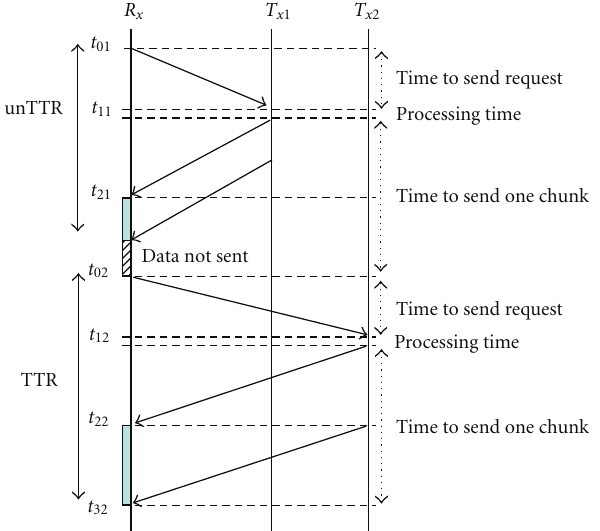
Figure 3: A peer churn event of length unTTR and successive successful request.